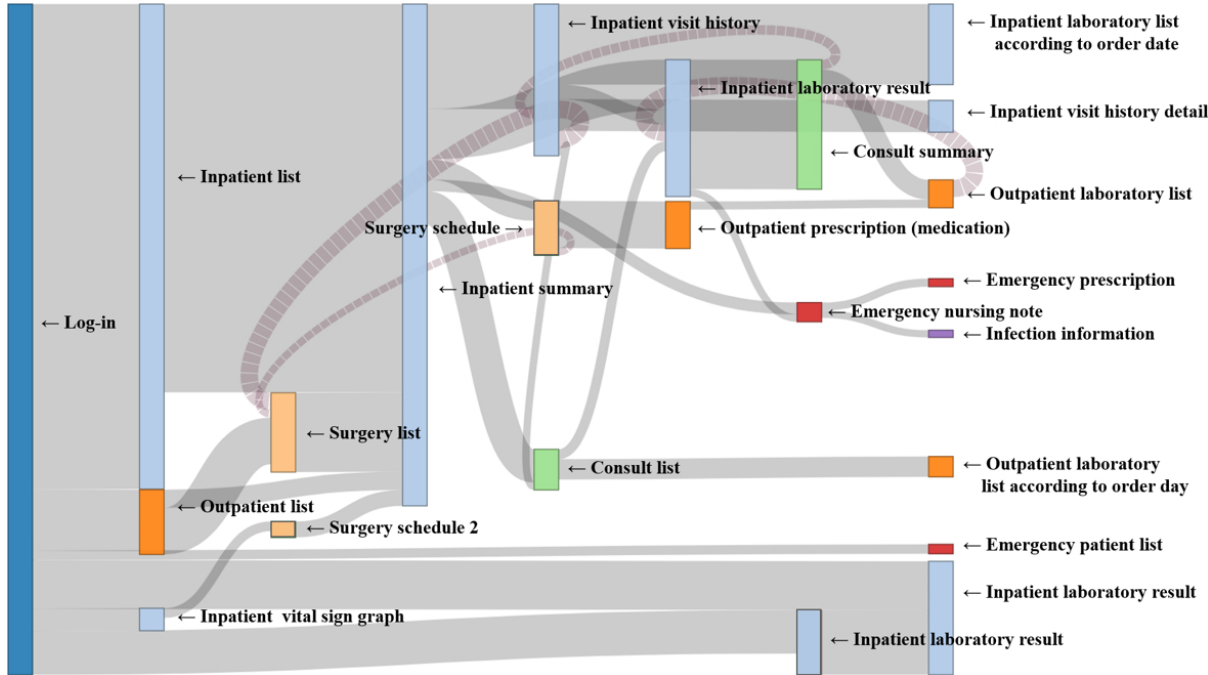
Figure 6. Sankey diagram of usage paths identified for the Physician group. Light blue, light green, light orange, orange and red colors were used to indicate impatient, consult, surgery, outpatient and emergency features, respectively.